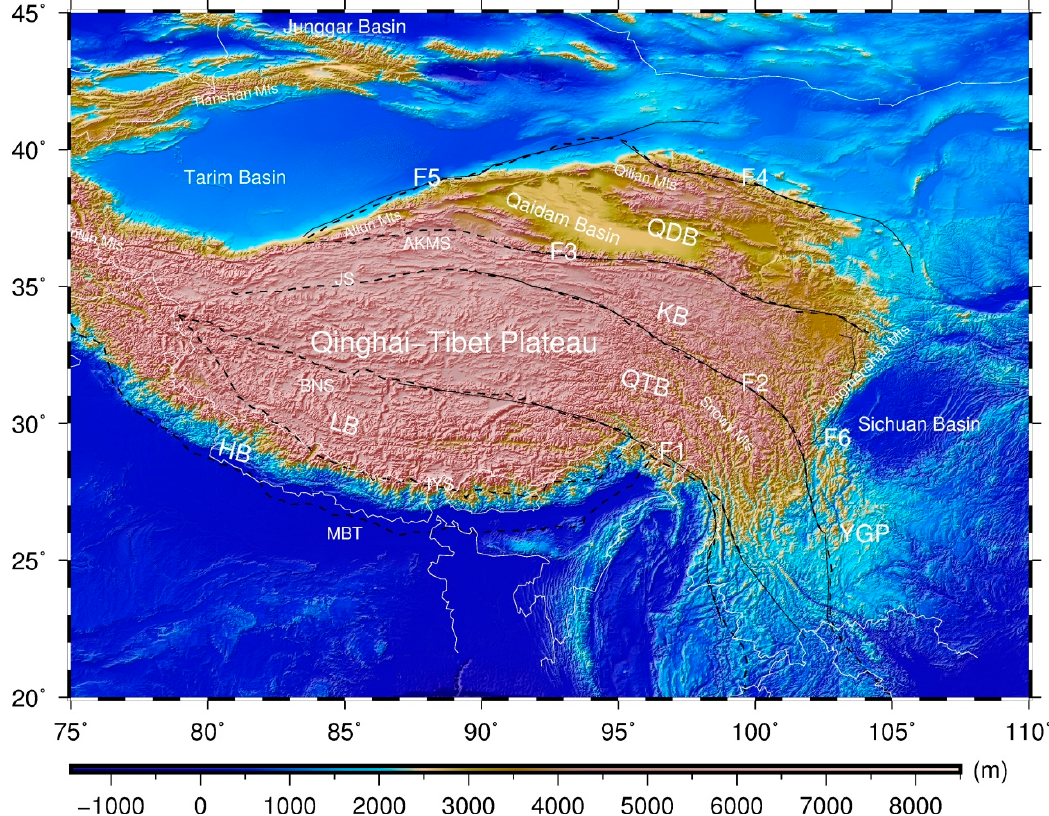
Figure 1. The topography and primary tectonic elements of study area (modified from [49]). The black dashed lines, black solid lines and white lines are bordering sutures, major faults and national borders, respectively. Key to symbols: HB, Himalayan Block; LB, Lhasa Block; QTB, Qiangtang Block; KB, Kunlun Block; QDB, Qaidam Block; YGP, Yunnan-Guizhou Plateau; MBT, Main Boundary Thrust; IYS, Indus-Yarlung suture; BNS, Bangong-Nujiang suture; JS, Jinshajiang suture; AKMS, Anyimaqen-Kunlun-Mutztagh suture; F1, Jiali Fault; F2, Manyi Yushu Xianshuihe Fault; F3, Kunlun Fault; F4, Haiyuan Fault; F5, Altyn Tagh Fault; F6, Longmenshan Fault.